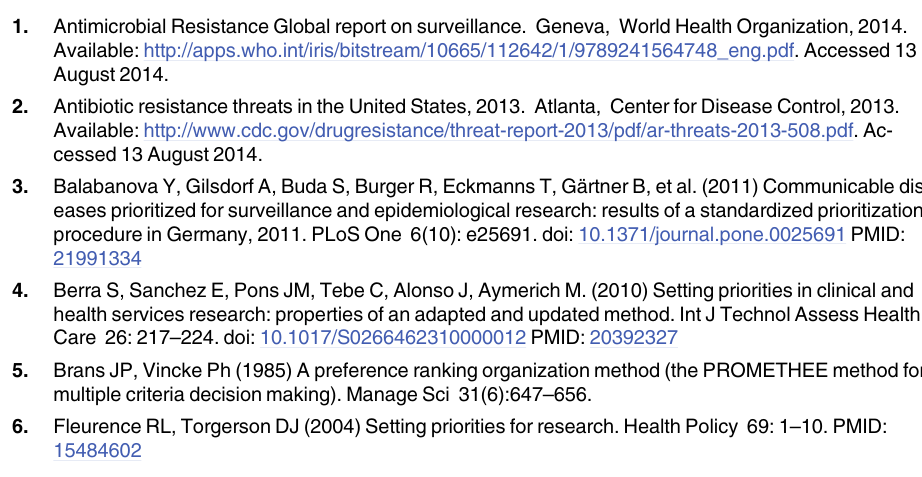
S1 Table. AMR pathogens prioritization — Results of pathogen scoring.